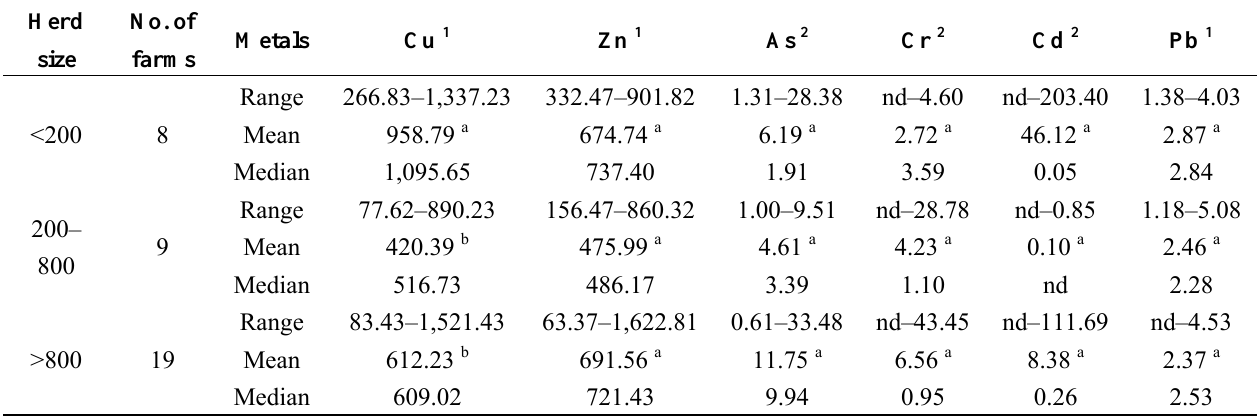
Table 7. Heavy metals in pig manure from farms of different herd size (mg/kg